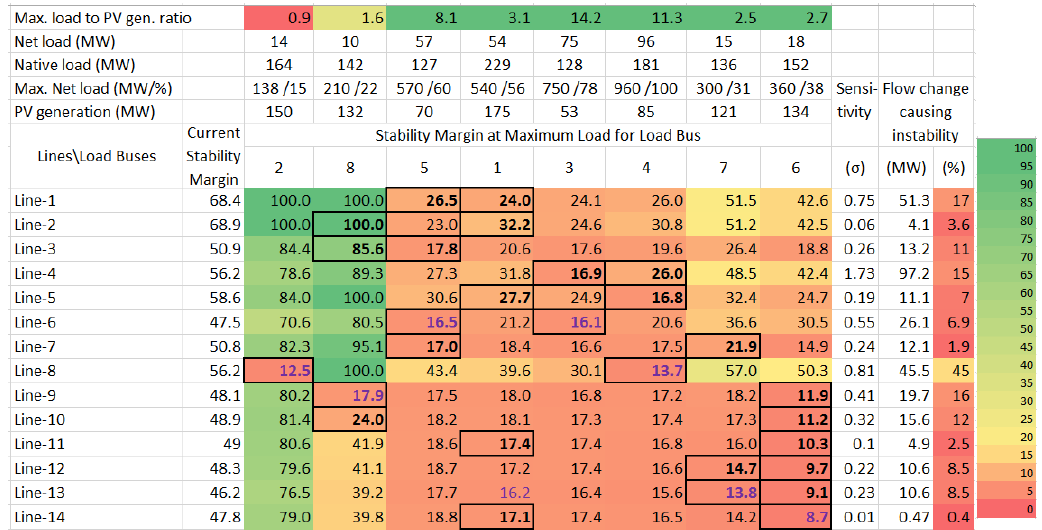
Figure 7. Heat map for stability margin analysis.